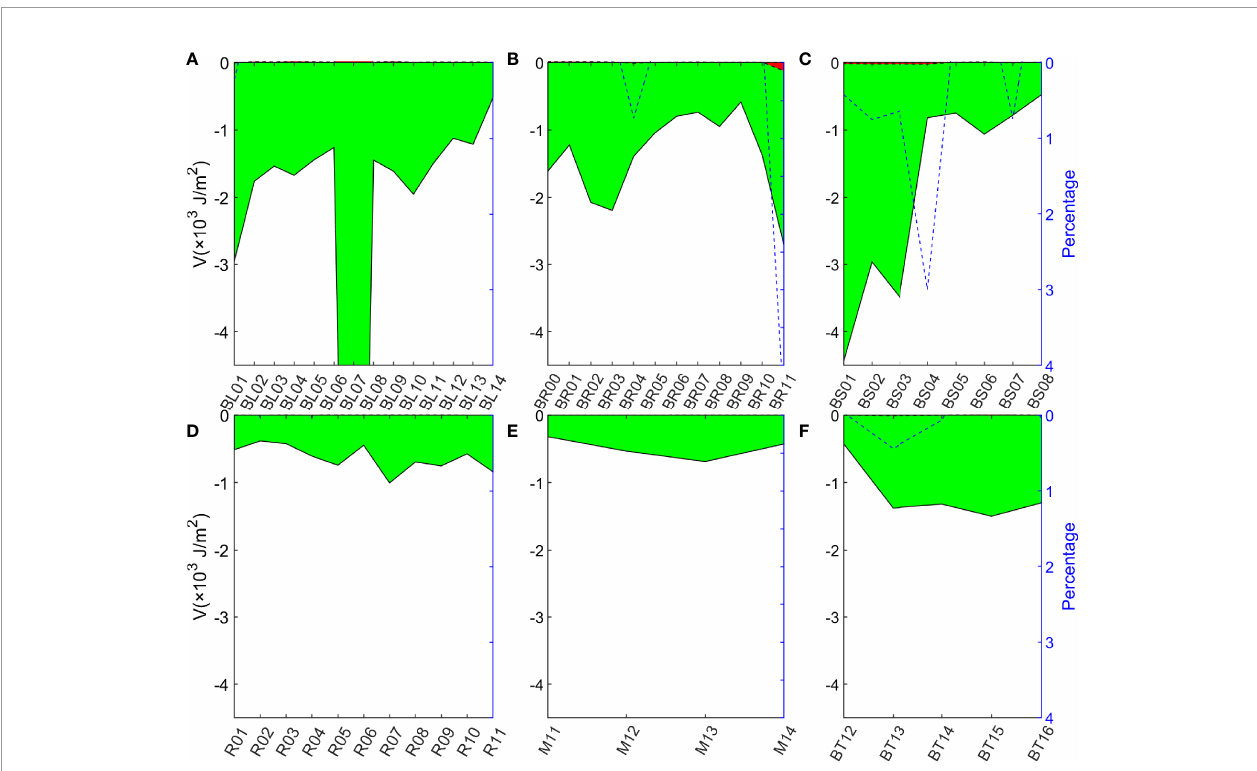
FIGURE 4 | The left axis represents the strati fi cation index. Red indicates the proportion of strati fi cation due to temperature. Green was the proportion due to salinity. The right axis represents the percentage of the contribution of the temperature. The blue dashed line represents the proportion of the contribution of the temperature to the strati fi cation at different stations. (A – F) represent BL, BR, BS, R, M, BT section,